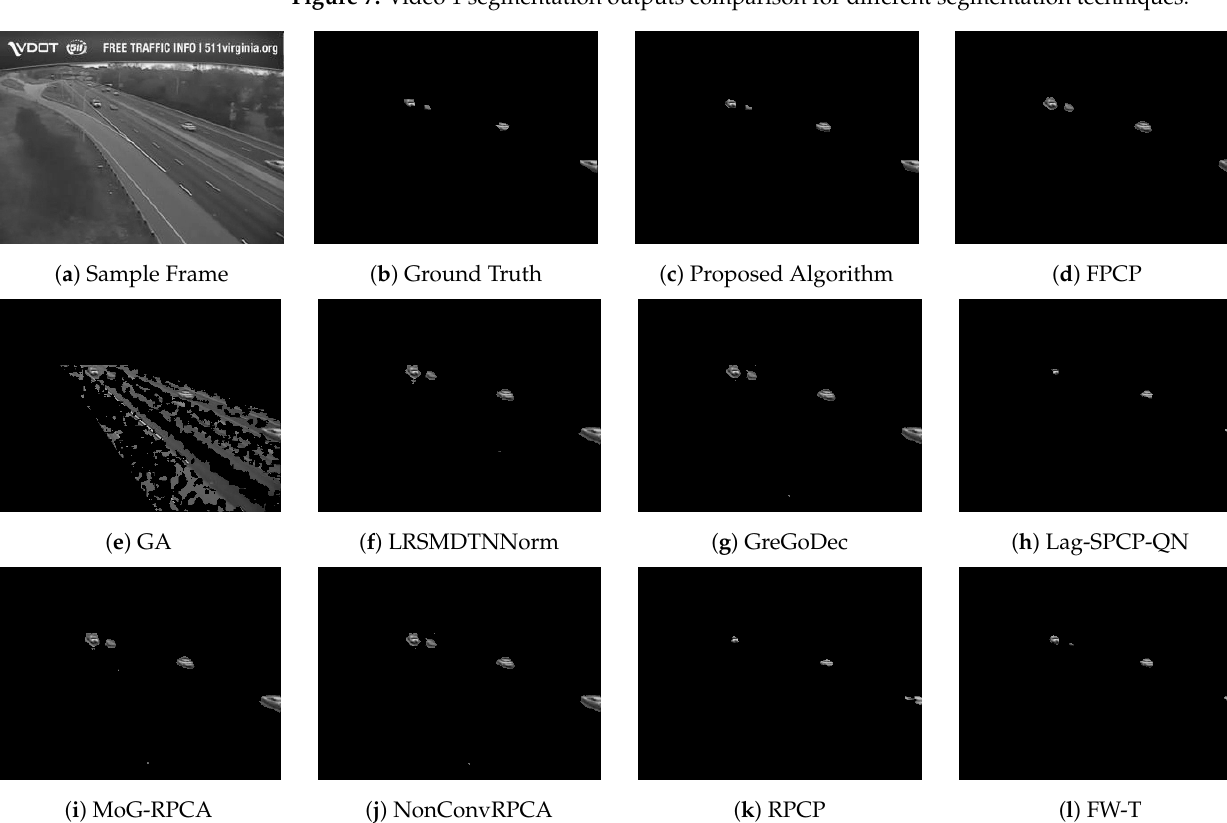
Figure 7. Video 1 segmentation outputs comparison for different segmentation techniques.